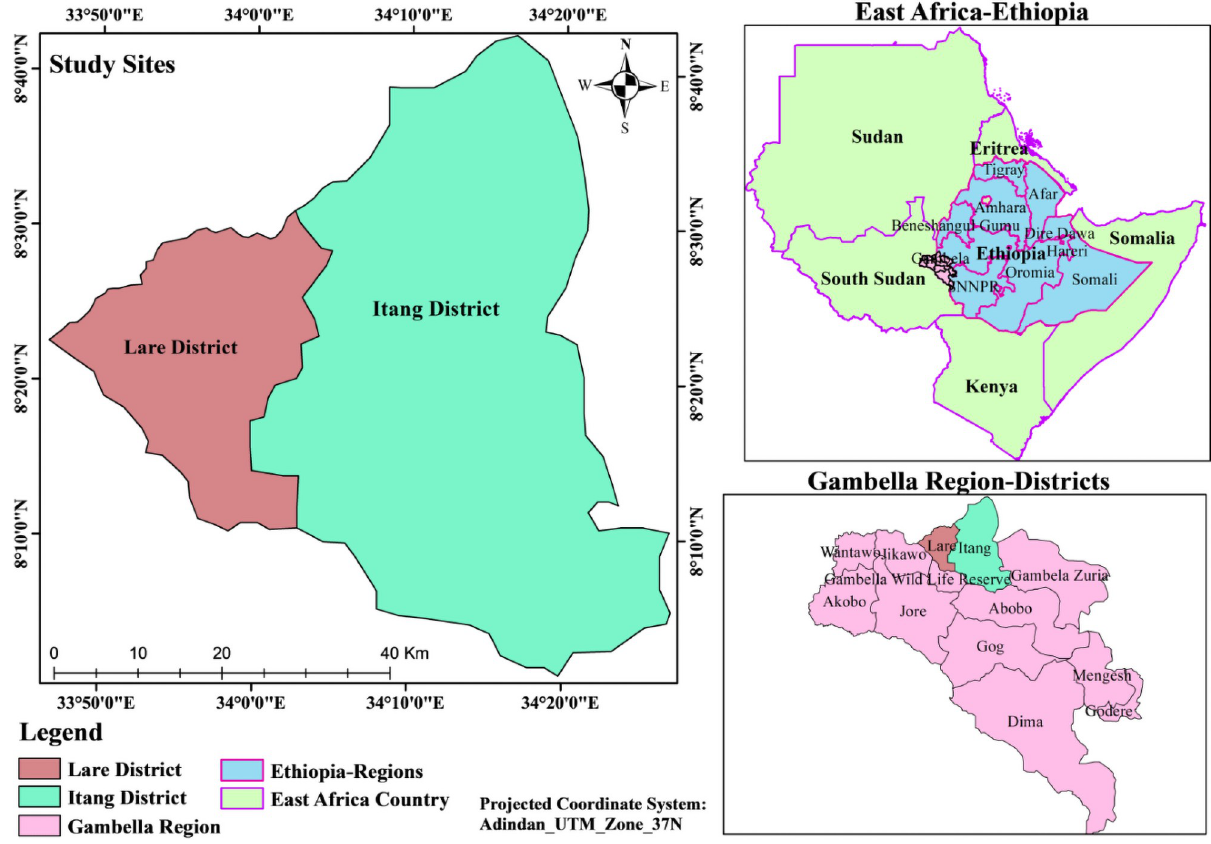
Fig 1. Map of the study site (Lare district and Itang special districts).